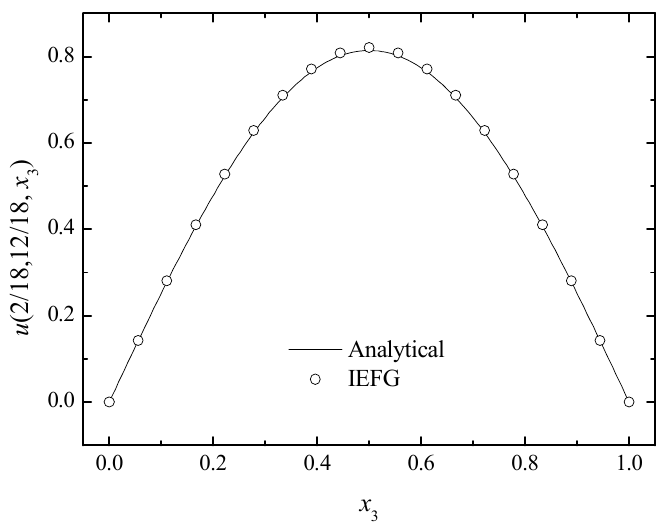
Figure 20. The numerical and analytical solutions of the IEFG method along the x 3 -axis.